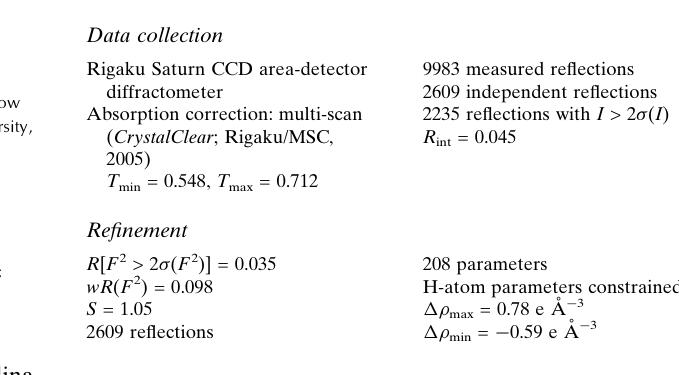
Rigaku Saturn CCD area-detector diffractometer